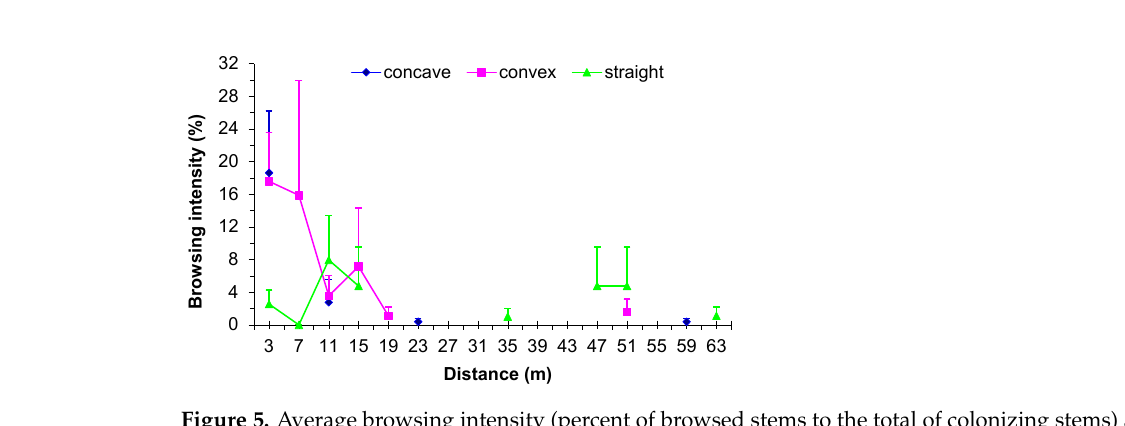
Figure 5. Average browsing intensity (percent of browsed stems to the total of colonizing stems) and standard error according to the distance to the forest edge (m) in the three boundary types (concave, convex, and straight).